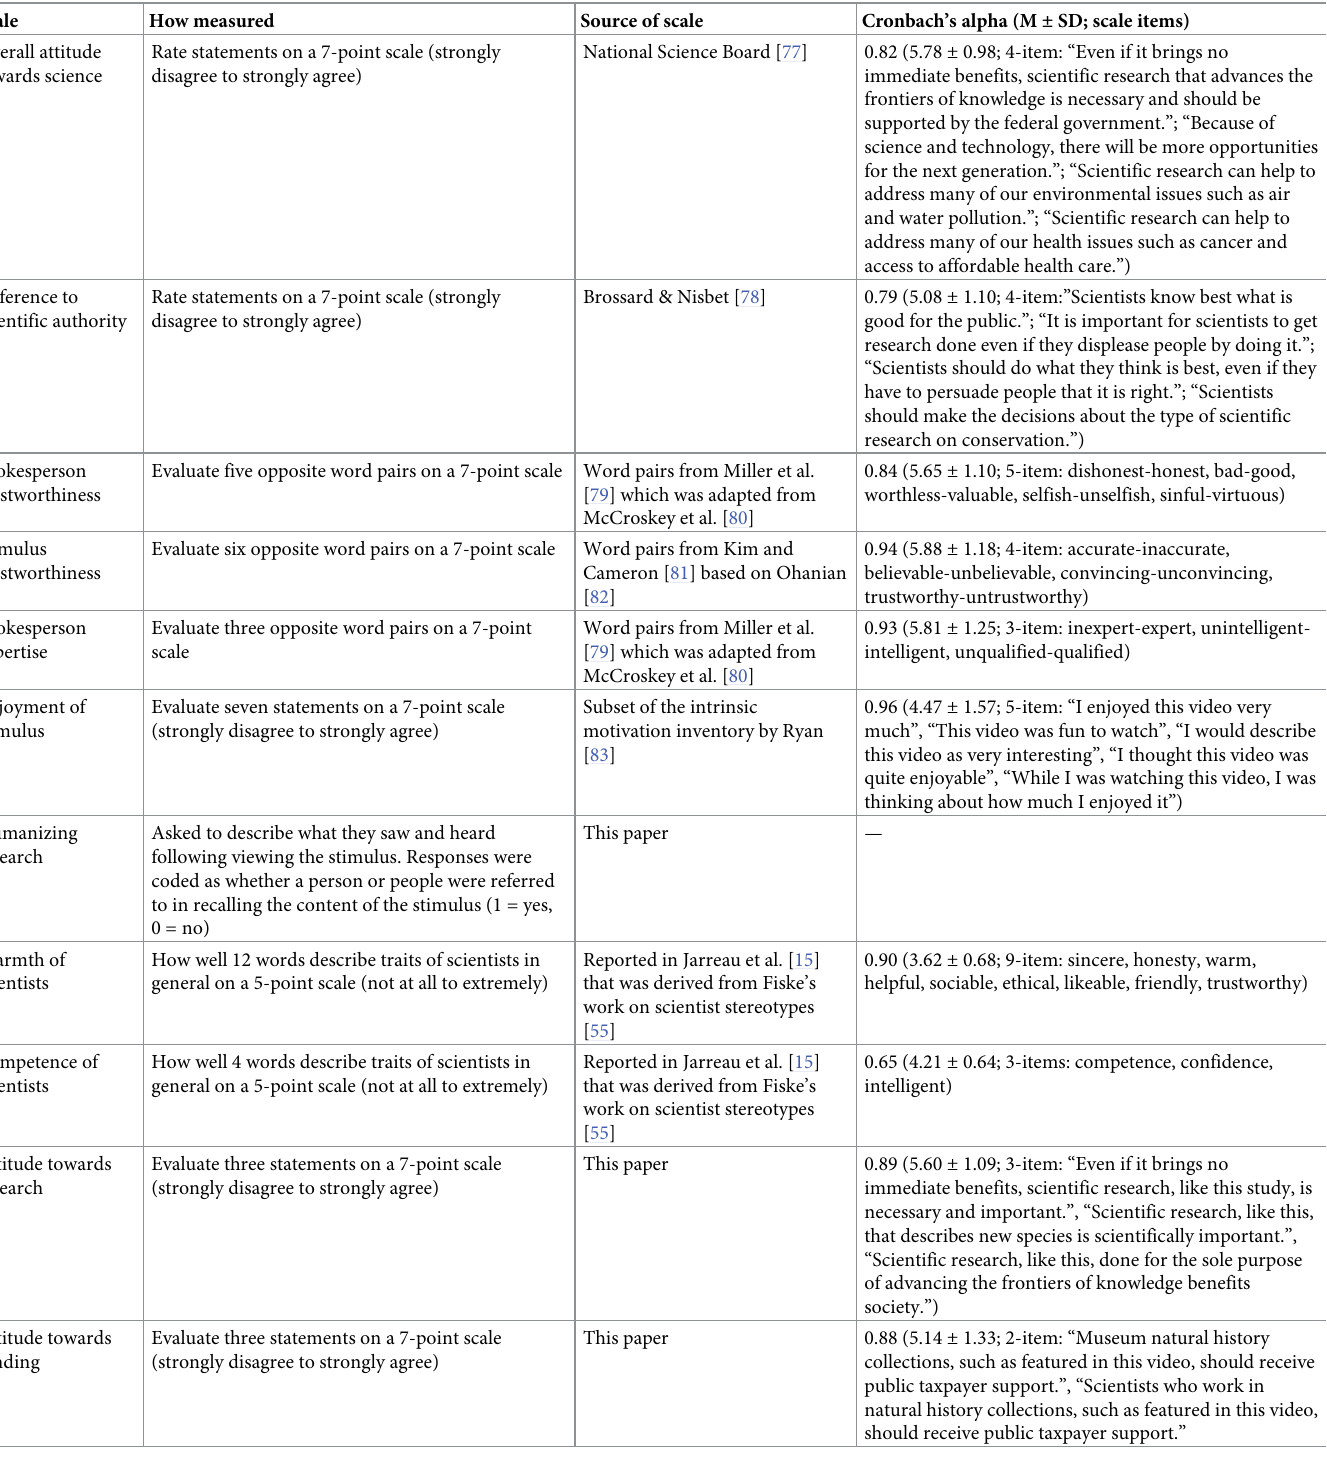
Table 2. Summary of the scales, how they were measured, their sources, and Cronbach’s